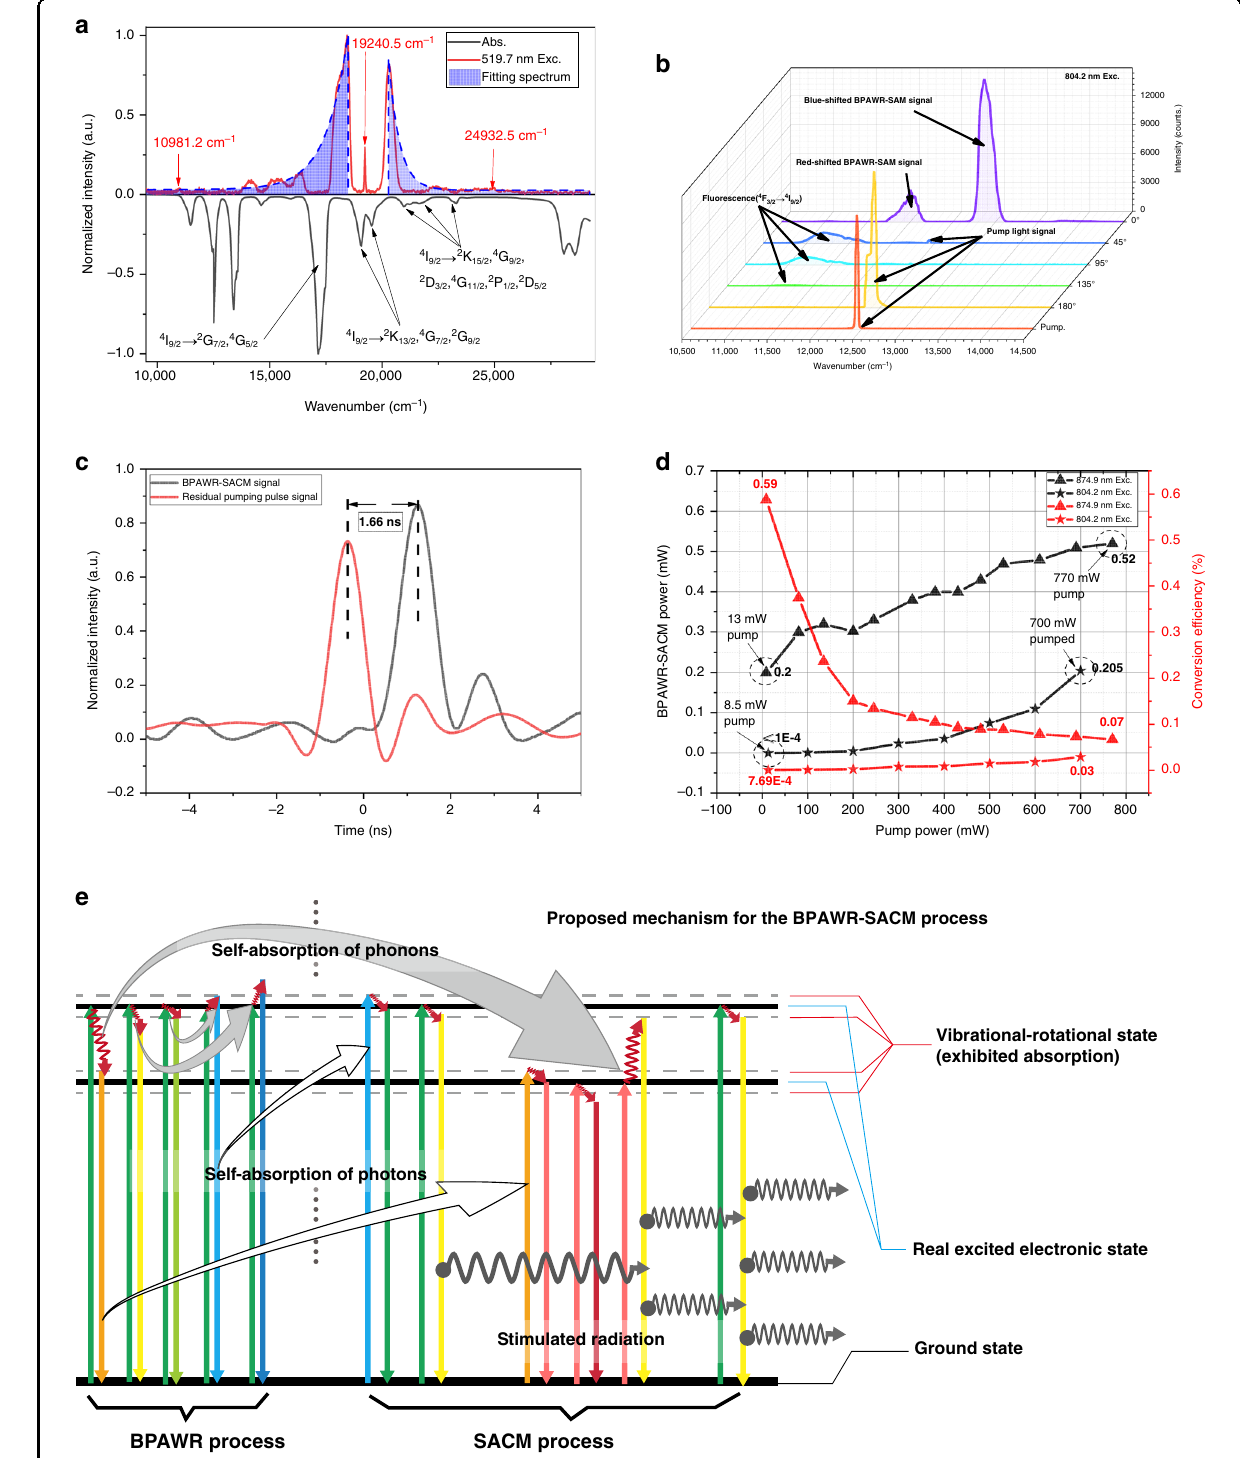
Fig. 2 Photo-physical properties of BPAWR-SACM process. a Normalized emission spectrum (upper part) and normalized absorption spectrum (lower part) in the visible light range. The corresponding transition modes of Nd 3 + ions are marked. The fi tting spectrum represents the hypothesized emission spectrum with non-absorption. b Emission spectra at different measurement angles relative to the forward direction of the excitation light. The corresponding excited energy levels are marked in the fi gure. c Time-delay measurement between the residual pump pulse and the generated frequency-shifted radiation. d BPAWR-SACM signal power and conversion ef fi ciency versus pump power of laser excitation at 874.9 nm (denoted as 874.9nm Exc.) and 804.2 nm (denoted as 804.2 nm Exc.). e The suggested mechanism for the BPAWR-SACM